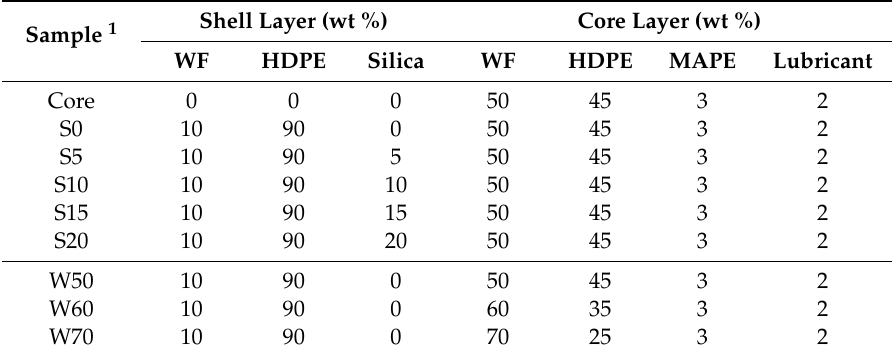
Table 2. Formulations of Co-WPCs filled with various contents of micro- or nanoscale silica and wood in the shell and core